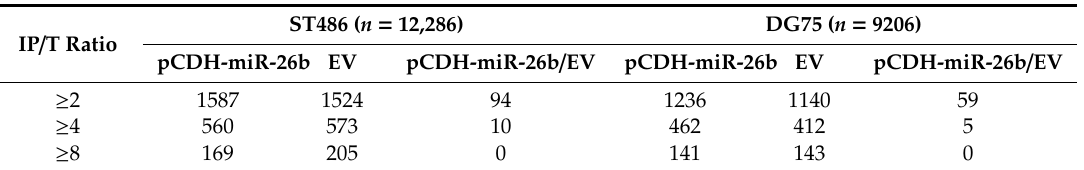
Table 1. Number of Ago2-IP enriched genes in the miR-26 overexpressing and control BL cell lines, and the number of miR-26b-5p target genes in ST486 and DG75. ST486 ( n = 12,286) DG75 ( n = 9206) IP / T Ratio pCDH-miR-26b EV pCDH-miR-26b / EV pCDH-miR-26b EV pCDH-miR-26b / EV ≥